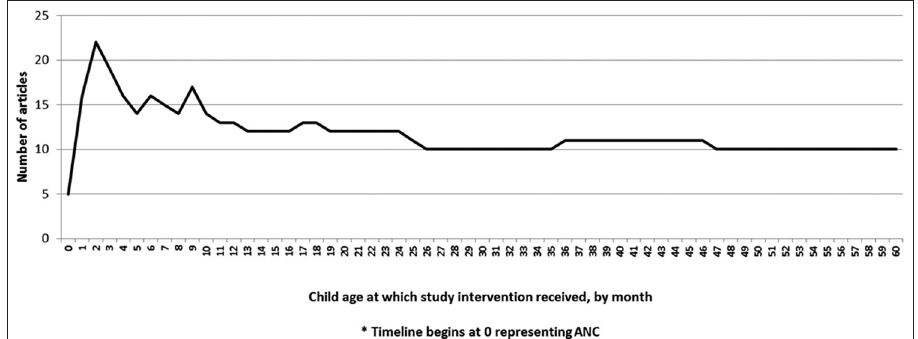
Figure 3: Number of Articles and Age of Child Receiving Study